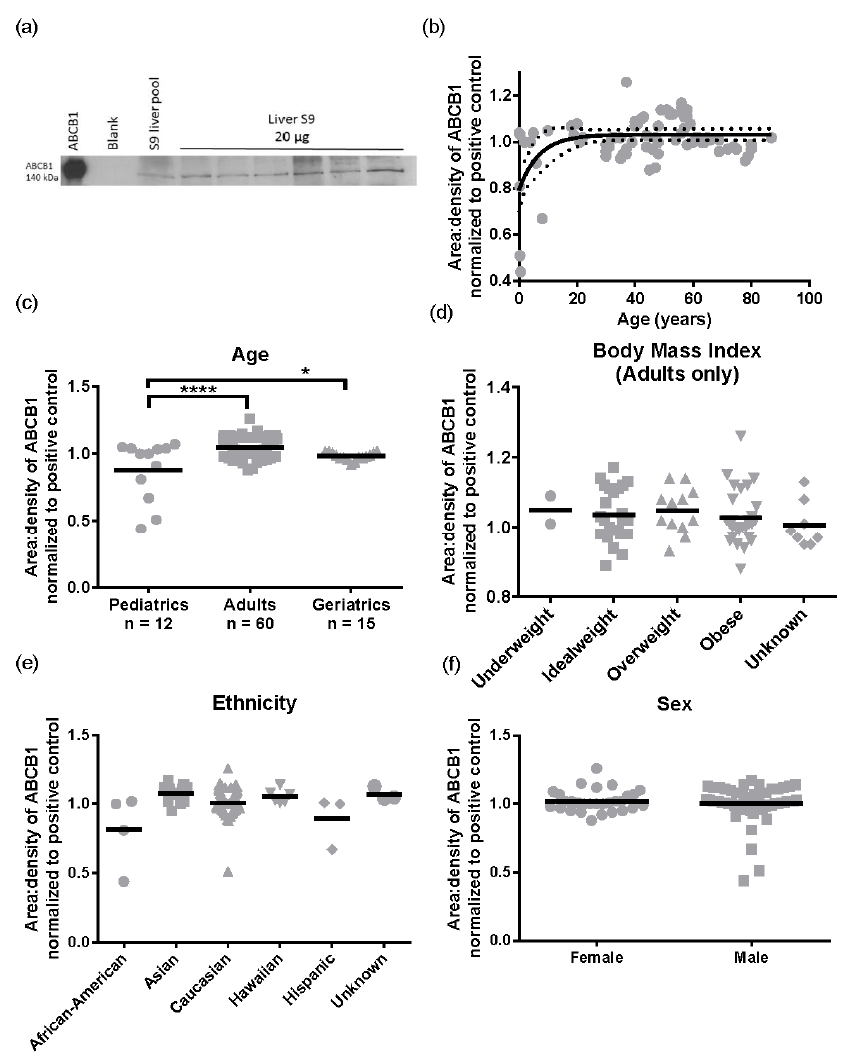
Figure 5. Protein expression of ABCB1 in a liver cohort. The ABCB1 protein was detected by Western blotting and normalized to the ABCB1 levels detected in a pooled S9 liver sample (Xenotech, n = 200 individuals). ( a ) Example of Western blot of 6 individuals with 20 µg liver S9 loaded compared with pooled S9 sample, ABCB1 = recombinant ABCB1 expressed in baculosome (5 µg), and blank = baculosome with no expression (5 µg); ( b ) Relationship between age and ABCB1 protein expression with a one-phase association, with 95% confidence intervals (dotted line); ( c ) Protein expression compared to individuals grouped by age and analyzed by ANOVA ( p < 0.0001) and ABCB1 expression in pediatrics was significantly lower compared to adults and geriatrics (Tukey’s multiple comparison test, *** p < 0.0001, * p < 0.05); ( d ): Expression of ABCB1 protein in obese individuals, measured by BMI; ( e ): Differences between ethnicity and ABCB1 protein expression; ( f ): The expression of ABCB1 proteins compared to sex.